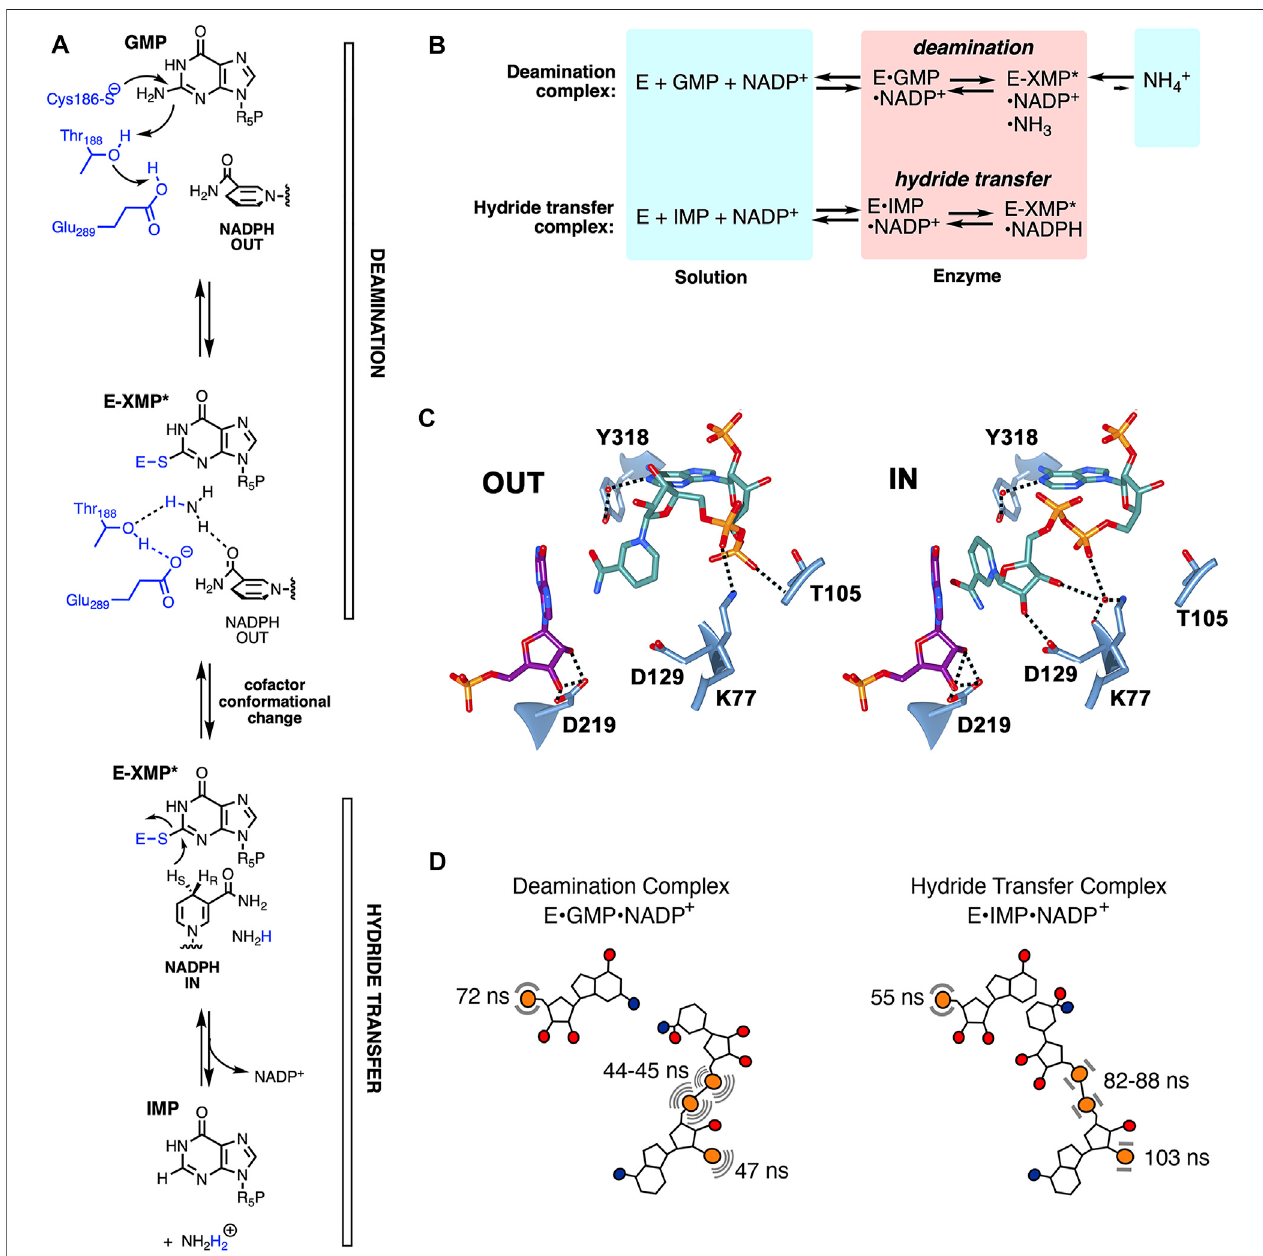
FIGURE 2 | The dynamics of enzyme-bound substrate and cofactors in GMPR. (A) The GMPR reaction. (B) Partial reactions catalyzed by GMPR. (C) Cofactor (cid:129) (cid:129) IMP NADP + crystal structure (pdb 2c6q). IMP carbon atoms are shown in dark magenta, NADP + in dark cyan, hydrogen bonds are conformations observed in E depicted with dashed lines. This fi gure was produced with UCSF Chimera (Pettersen et al., 2004). (D) Cartoon showing the values of τ D in the deamination and hydride transfer complexes. The cofactor is more dynamic than the substrate in the deamination complex while the substrate is more dynamic than the cofactor in the hydride transfer complex. (A,B) were reprinted with permission from (Rosenberg et al., 2020). Copyright 2020 American Chemical Society.